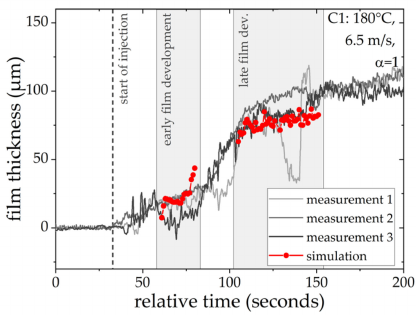
Figure 15. Comparison of AdBlue film thickness evolution during early and late injection stage for the configuration